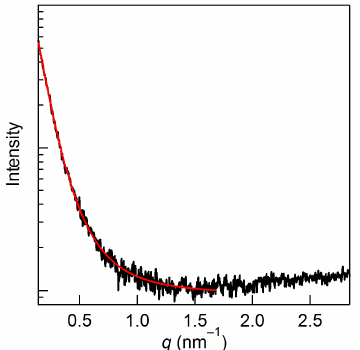
Figure 6. A single logarithmic SAXS pattern of the mixture at 25 mol %. The Debye–Bueche equation was applied (red line) to reproduce the experimental pattern.